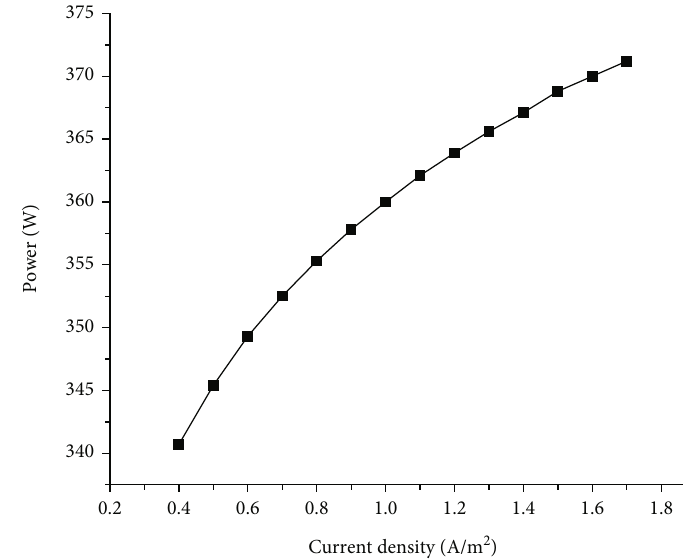
Figure 21: Current density characteristics of